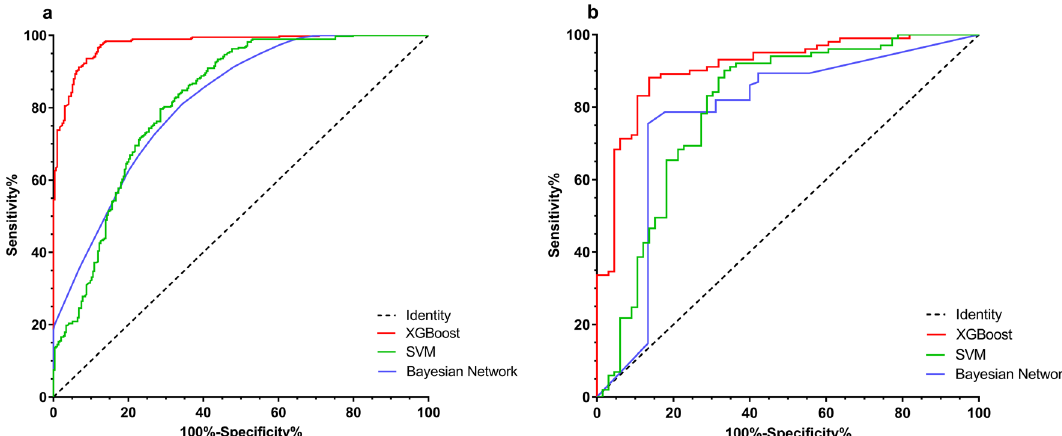
Figure 4. Receiver operating characteristic curves showing the predictions of the three models: XGBoost, SVM, and the Bayesian network. ( a ) The training set, ( b ) the validation set. XGBoost, extreme gradient boosting; SVM, support vector machine. The figure was created by using GraphPad Prism 7 (https ://www.graph pad. com/).